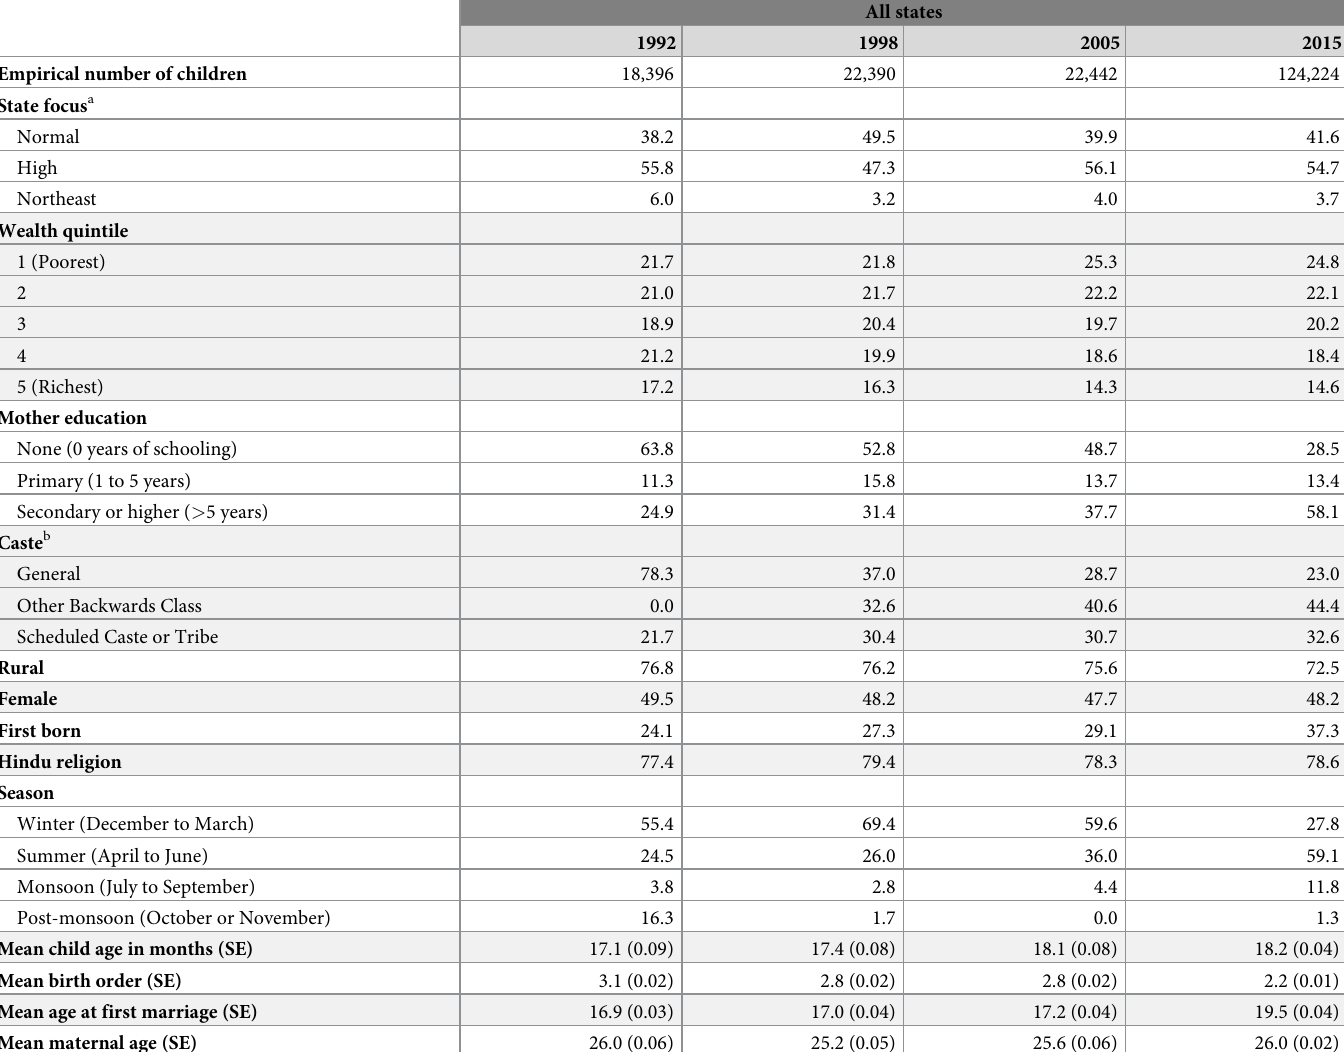
Table 1. Weighted distribution of eligible children under the age of 3 measured for undernutrition in Indian NFHS from 1992 to